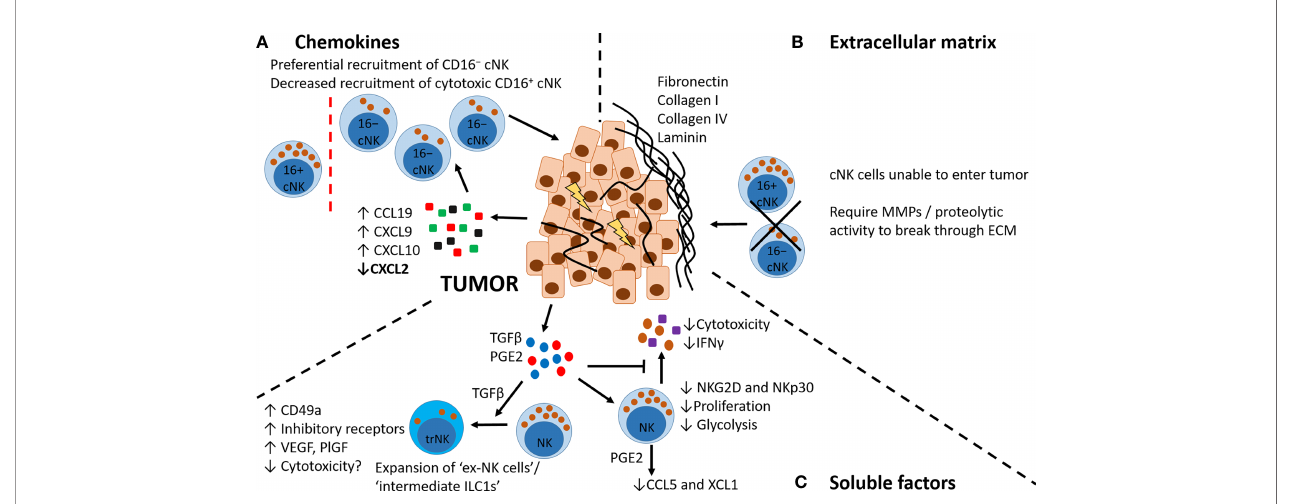
FIGURE 4 | Factors affecting NK cell recruitment to tumors. (A) Chemokines. Tumor cells and immune cells in the TME produce increased levels of CCL19, CXCL9 and CXCL10 and decreased levels of CXCL2, which may preferentially recruit CD16 − NK cells expressing CCR7 and CXCR3. (B) Extracellular matrix. Tumors can be surrounded by a dense ECM layer that restricts or prevents NK cell entry from the circulation. Entry requires speci fi c proteolytic activity, e.g. MMPs. (C) Soluble factors. Tumor cells and immune cells in the TME secrete soluble factors including TGF b and PGE2. TGF b can promote a phenotypic switch in NK cells to a more trNK cell-like phenotype (also known as ex-NK cells, and intermediate ILC1s), with increased expression of CD49a, increased production of pro-angiogenic factors VEGF and PlGF, and increased expression of inhibitory receptors. These trNK cells may also have decreased cytotoxicity. TGF b and PGE2 have other inhibitory effects on NK cells, including reducing NK cell cytotoxicity, decreasing in fl ammatory cytokine production, decreasing proliferative capacity and altering their metabolic activity (decreasing glycolysis). PGE2 can also alter NK cell chemokine production, decreasing secretion of CCL5 and